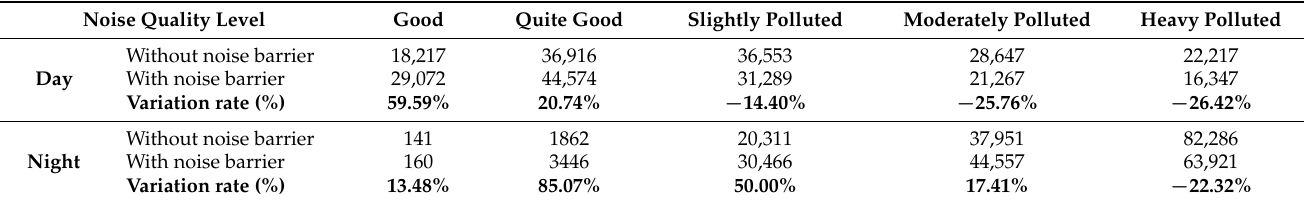
Table 7. Population under different noise quality levels (“ − ” indicates a decrease).